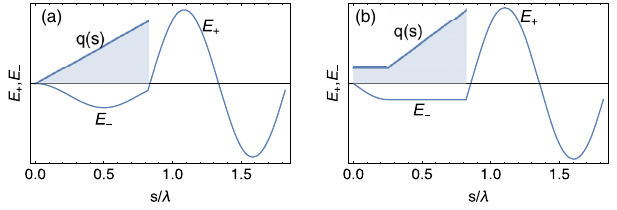
FIG. 1. Electron density distribution and normalized wake field. See text for explanation of the specific plots.